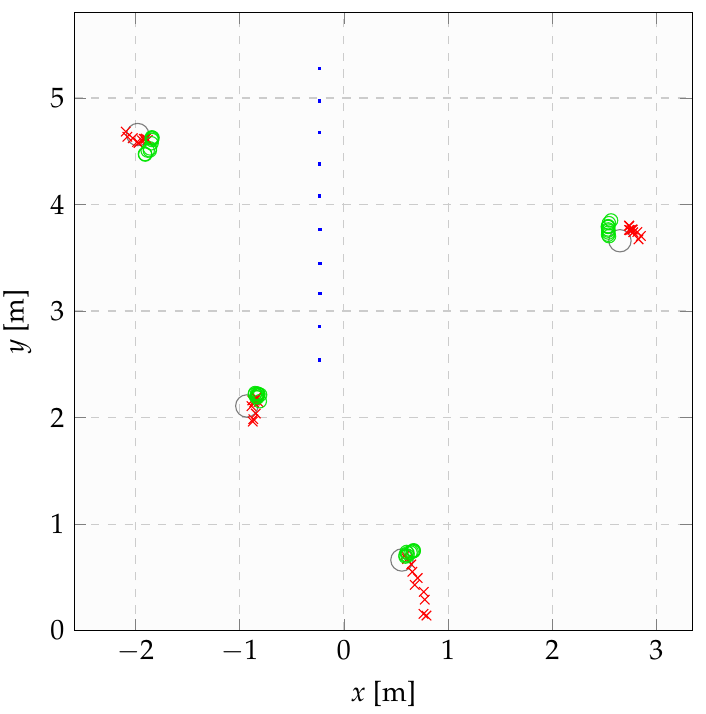
Figure 13. Example of the effects of the proposed calibration procedure on a field experiment. The actual sensor positions are plotted with a series of practically aligned blue dots, the true cylindrical landmarks in gray circles, the raw measurements taken by the sensor with red crosses, and the filtered distances, computed using the proposed strategy, in green circles. Ideally, the measurements should lie on the borders of the landmarks. It is immediately noticeable how the calibrated measurements lie much closer to such borders than the non-calibrated ones.